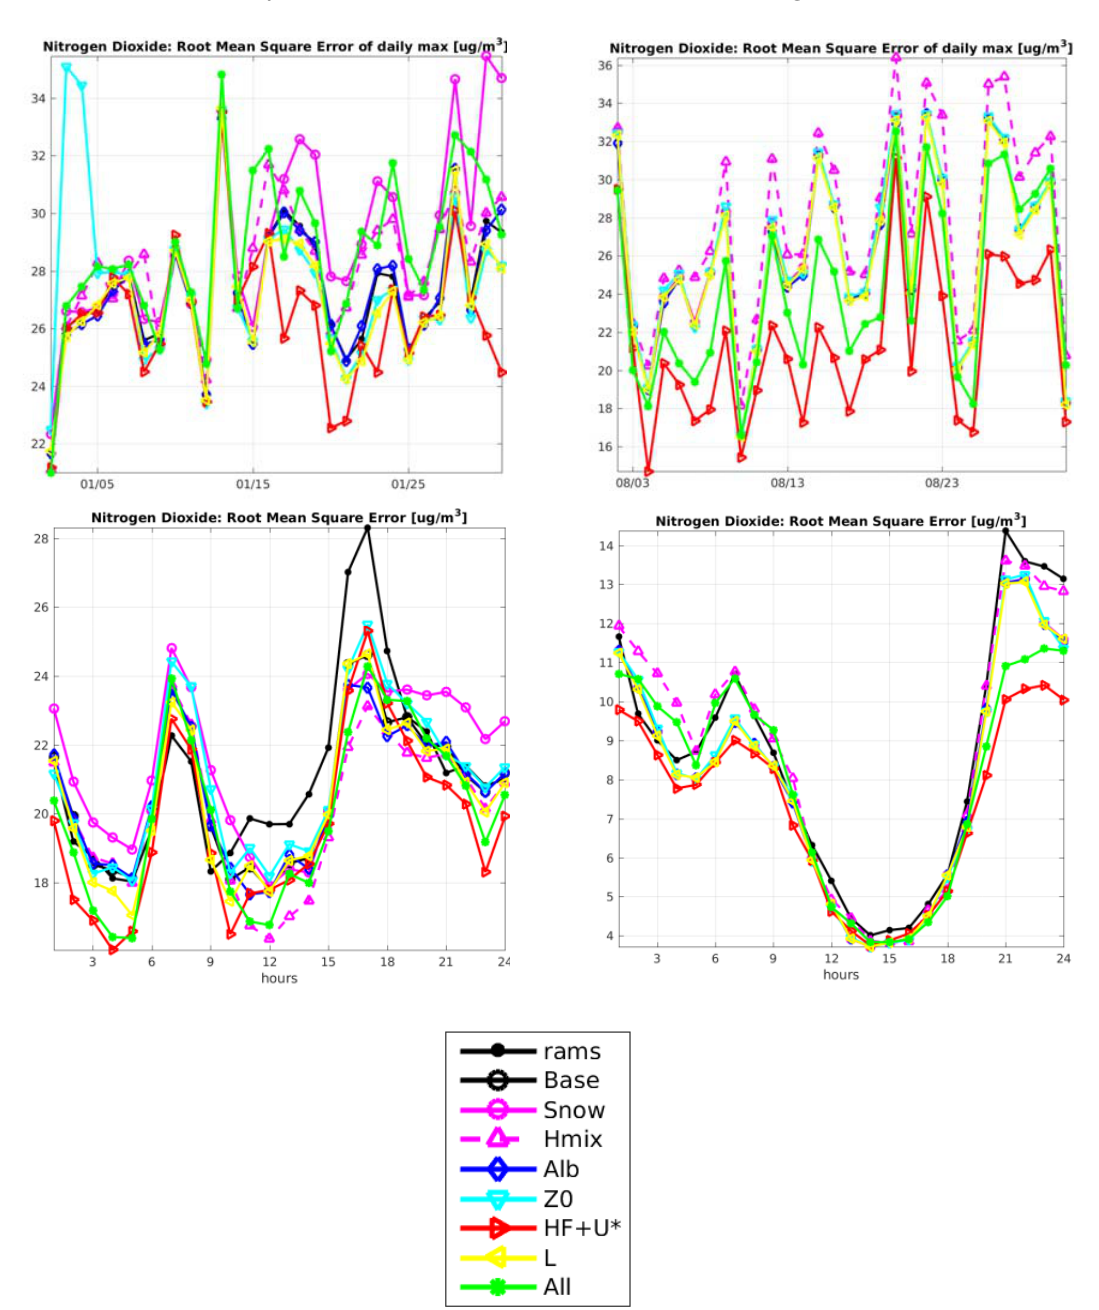
Figure 5. NO 2 —RMSE of the daily maximum of hourly concentrations (upper panel) and of hourly concentrations (lower panel), for January (left) and August (right). The x -axis reports UTC times. R (Figure 6, upper panel) has low values on average, ranging from 0.25 to 0.5 in January and from 0.15 to 0.45 in August. In January, Z0 performs worst, HF+U* has the highest values from 1.00